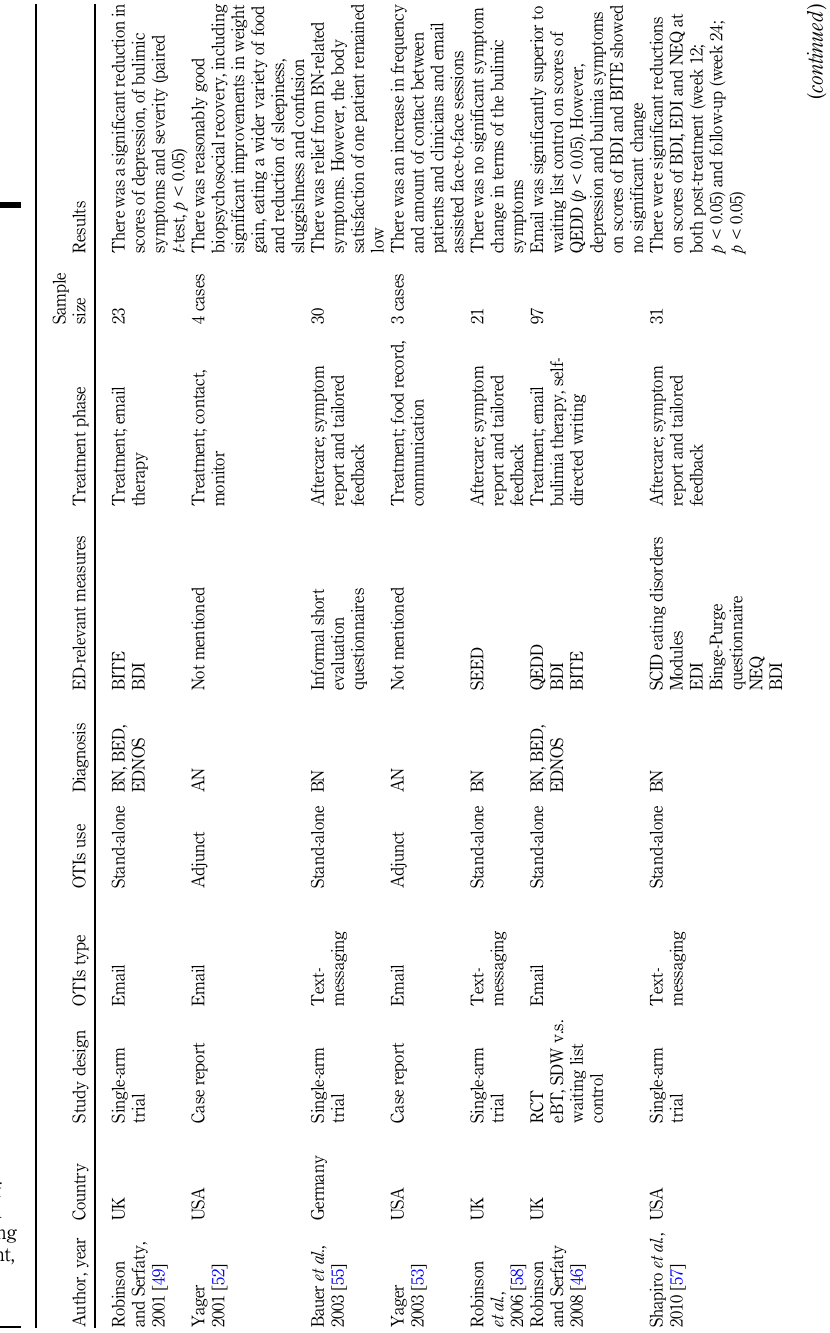
Table 1. Characteristics of studies included in mixed methods systematic review of text-based telehealth interventions in eating disorder